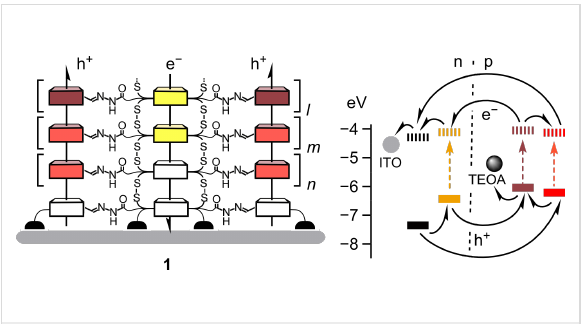
Figure 1: Schematic structure of photosystem 1 on indium tin oxide (ITO, grey) with antiparallel gradients in hole (p, h + ) and electron (n, e − ) transporting coaxial channels. HOMO (solid) and LUMO levels (dashed) of all components (color coded) are indicated in eV against vacuum ( − 5.1 eV for Fc/Fc + ), including triethanolamine (TEOA), used as mobile hole transporter.